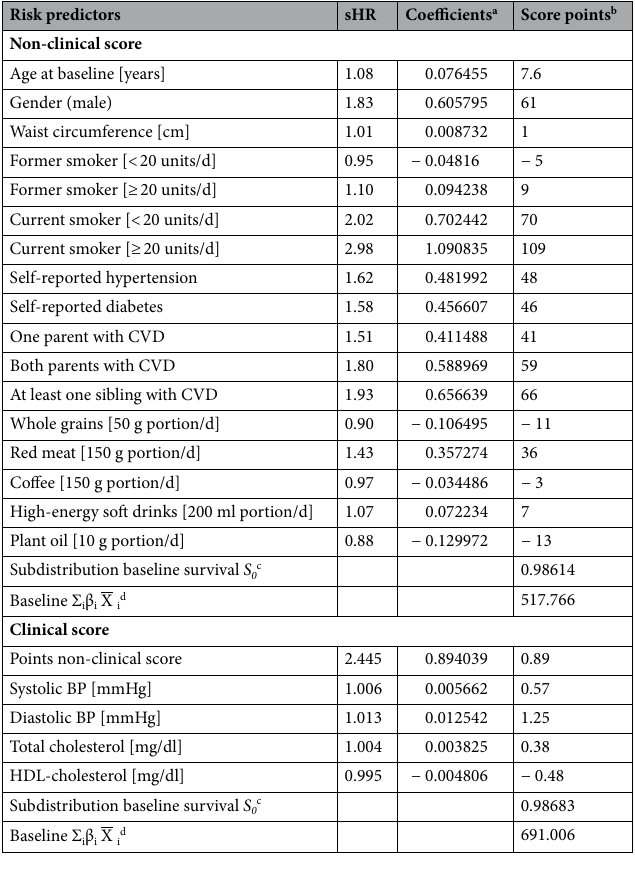
Table 2. Risk associations of the included predictors with CVD and parameters used for absolute risk calculation. Risk associations are mutually adjusted and depicted as hazard ratios. sHR, subdistribution hazard ratio. CVD, cardiovascular disease. BP, blood pressure. HDL, high density lipoprotein. a β coefficients estimated by Cox proportional hazards regression. b β coefficients were rounded and multiplied by 100 to derive according score points for absolute risk calculation. c S 0 , baseline subdistribution survival used to calculate absolute risk. d Σ i β i X i , mean score points of all participants at